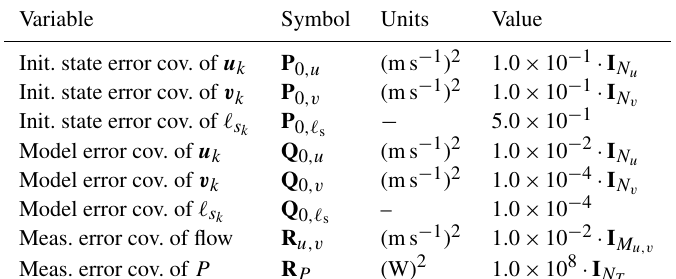
Table 2. Covariance settings for the KF variants, with I (cid:113) the R entries. For example, P 0 is diag (cid:0) P 0 ,u , P 0 ,v (cid:1) and diag (cid:0) P 0 ,u , P 0 ,v , P 0 ,(cid:96)